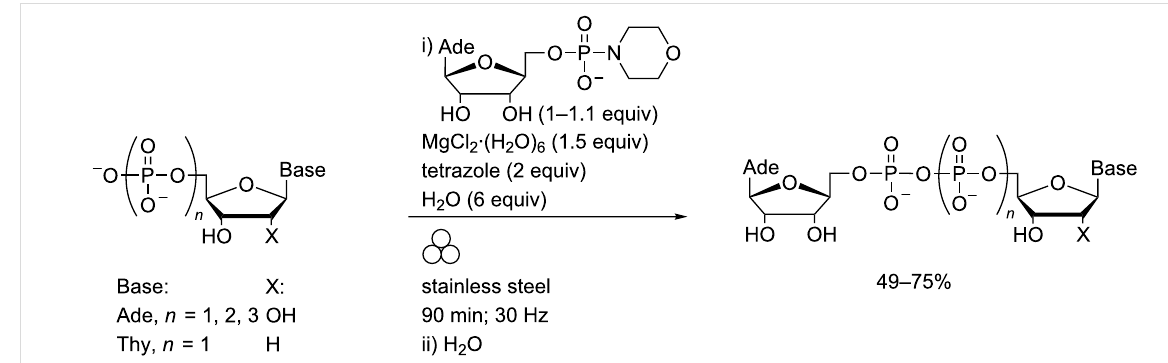
Scheme 13: Internucleoside phosphate coupling linkages in a MBM.